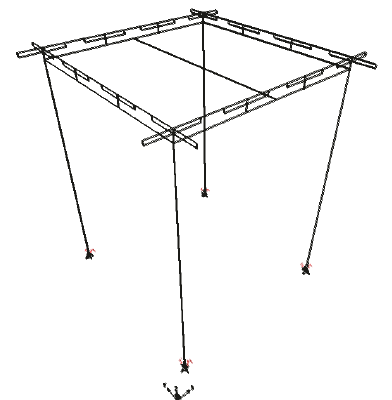
Figure 13: FEM of timber